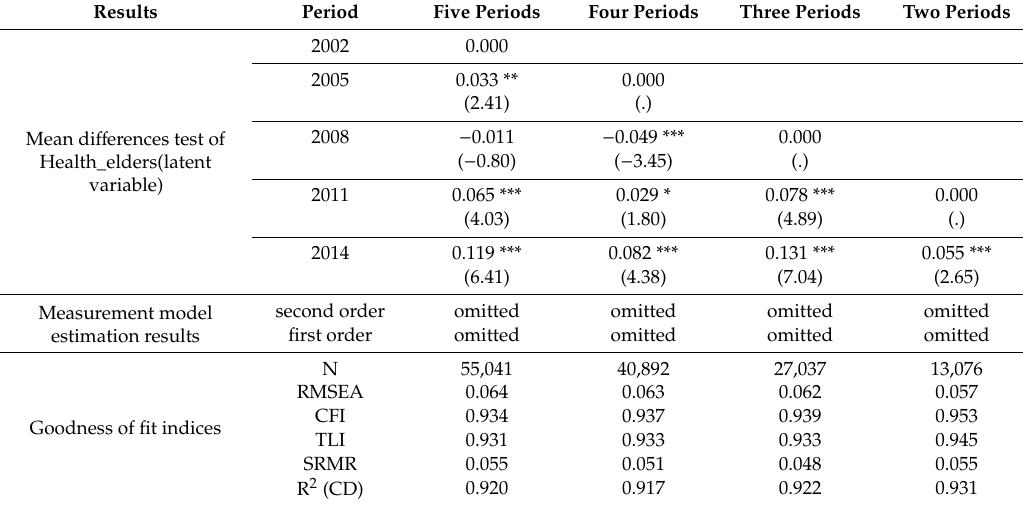
Table 4. Significance test of the latent variable’s mean di ff erences using a multiple-group comparison structural equation